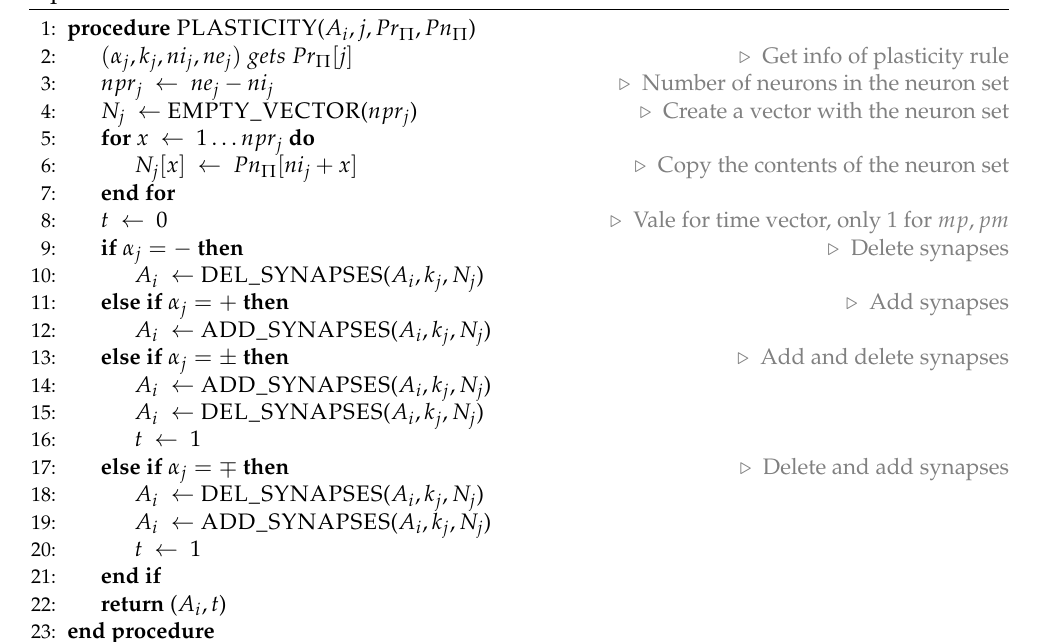
Algorithm 11 Function for plasticity mechanism using optimized compressed matrix